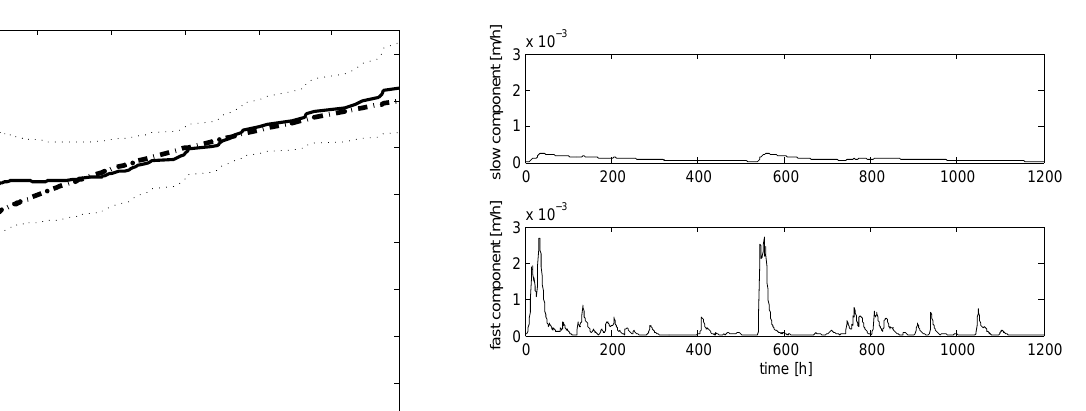
Fig. 2. The estimated slow (upper panel) and quick (lower panel) flow components of the DBM model output. The most likely in- terpretation of these component flows is that the slow component represents the “groundwater” (baseflow) effects and the quick com- ponent represents the “surface and near-surface” process